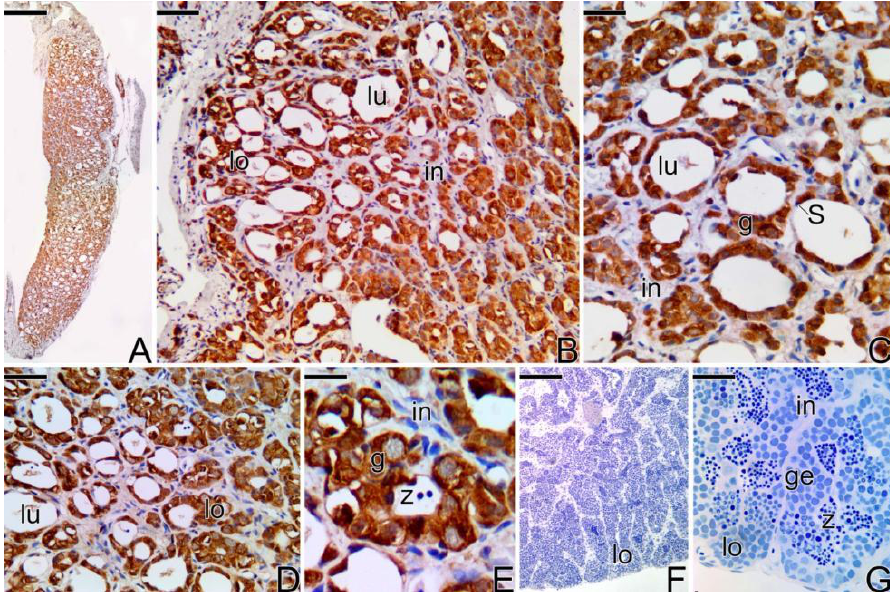
Figure 12. Immunohistochemistry for detection of metalloproteinases in testis of primary males of S.